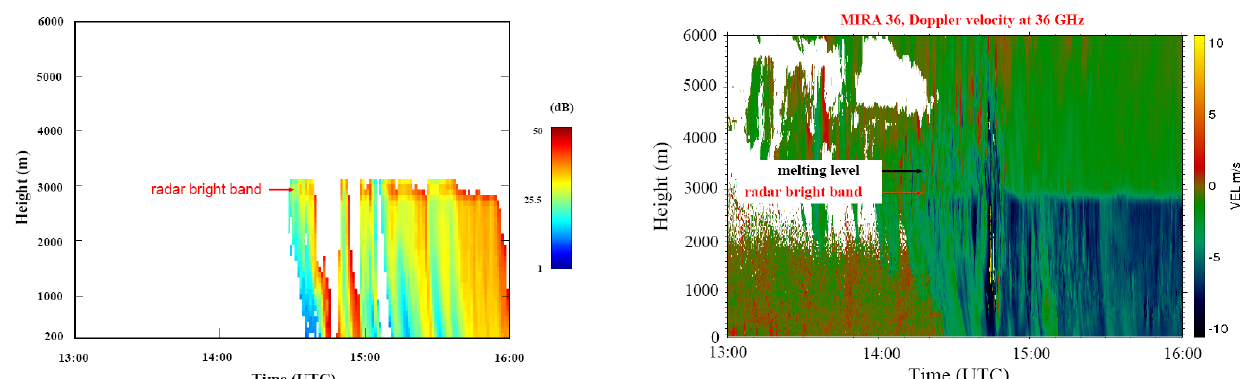
Figure 3. Time evolution of radar reflectivity at 35.5 GHz from 13:00 UTC to 16:00 UTC on 23 July 2007 as measured by MIRA 36. Arrows indicate the location of the melting level and the radar bright band.